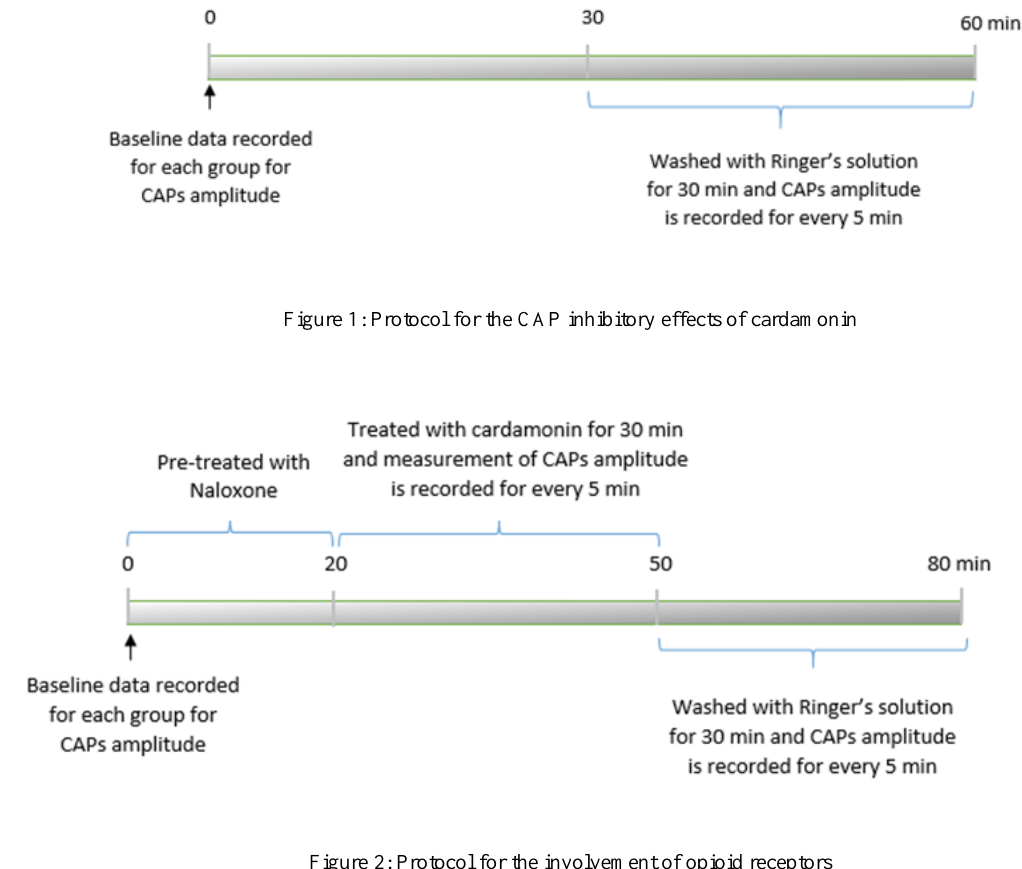
Figure 2: Protocol for the involvement of opioid